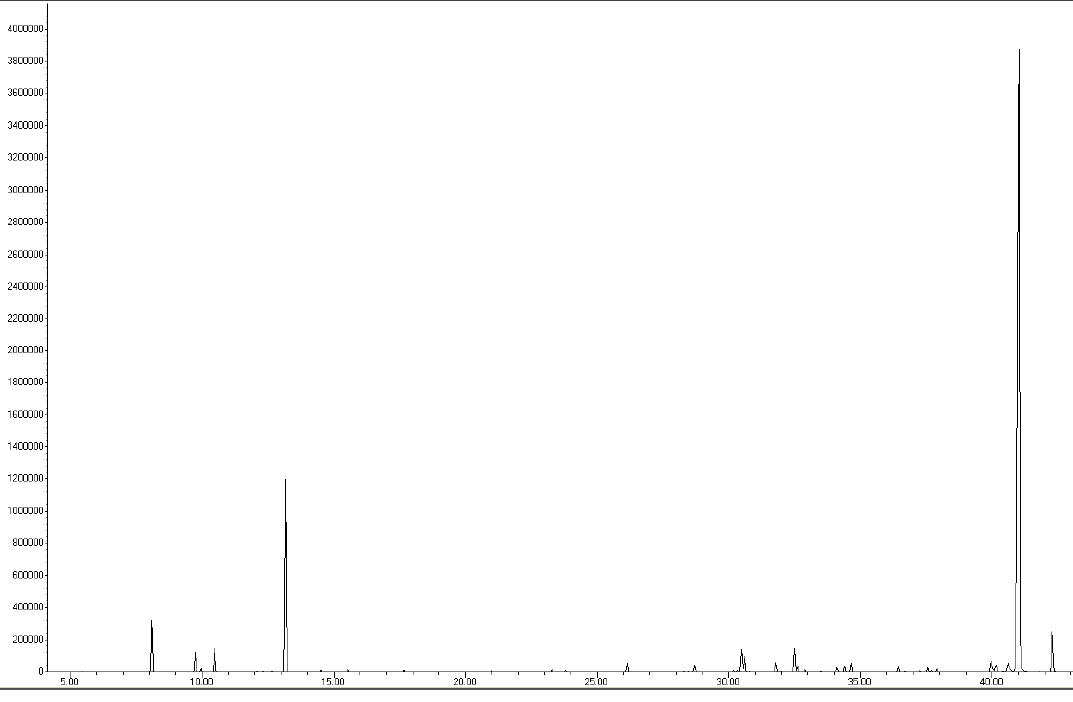
Figure 1. Typical gas-chromatogram of essential oil of Niphogeton dissecta .